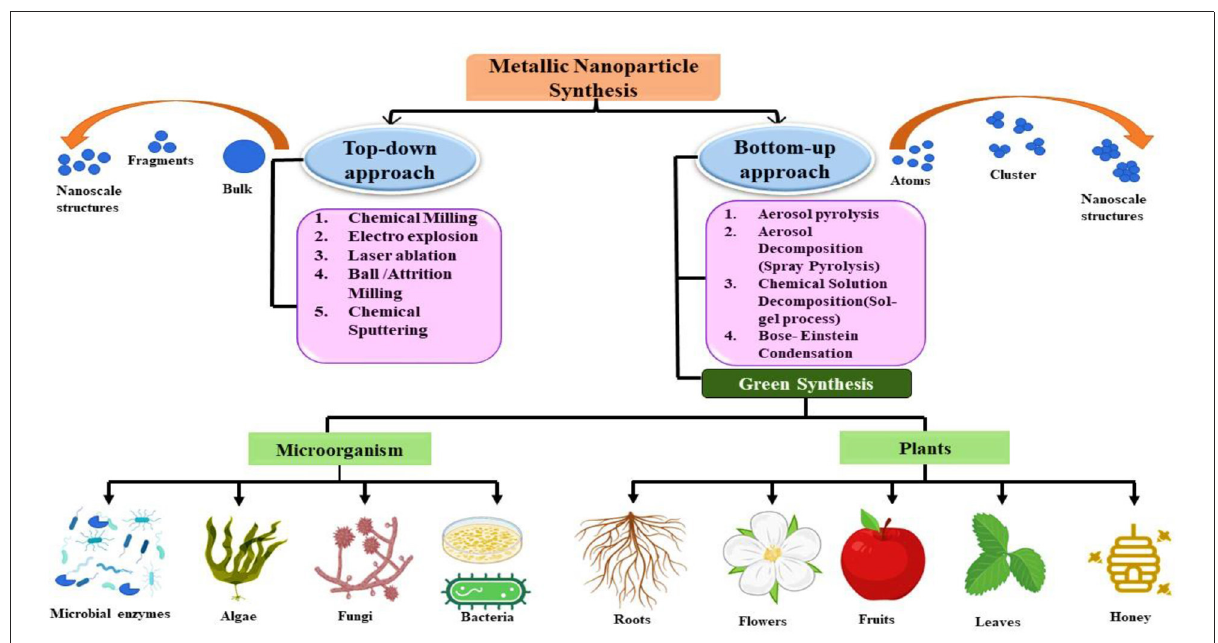
FIGURE1 Pictorial representation of nanoparticle formation using various